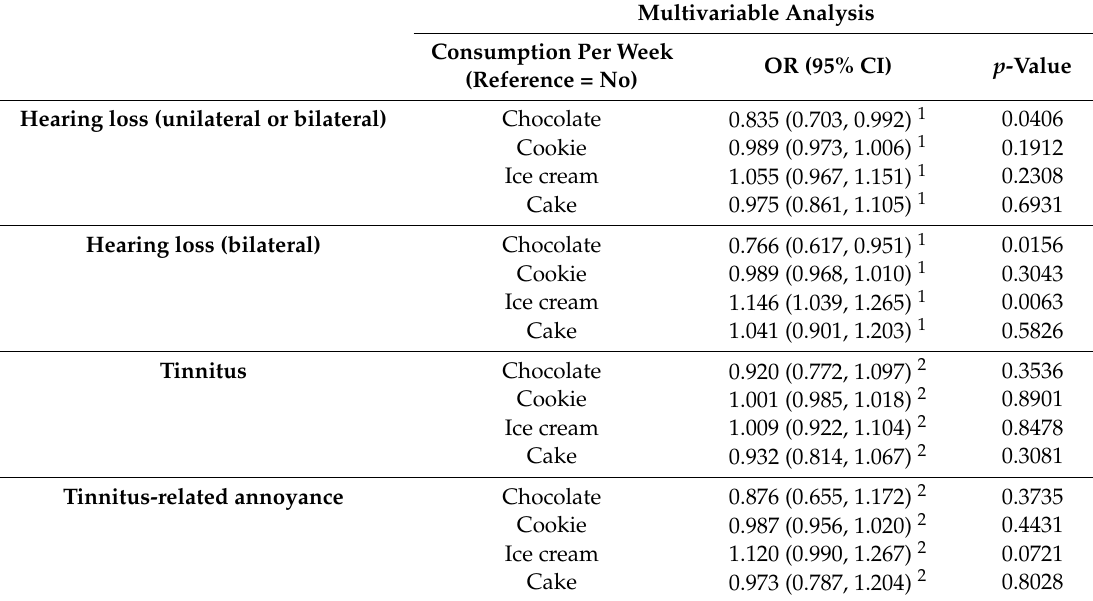
Table 3. Odds ratios and 95% confidence intervals for hearing loss and tinnitus according to consumption of chocolate and sweet products without